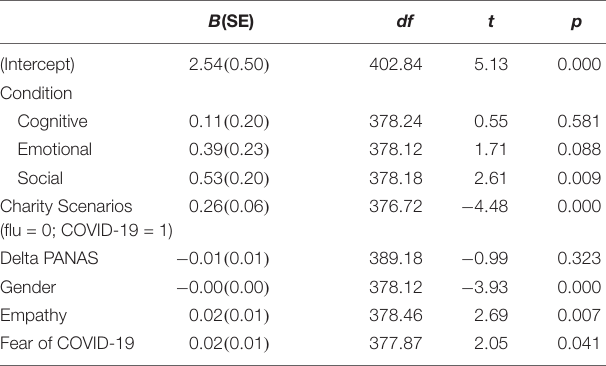
TABLE 3 | Multilevel linear regression model with willingness to help as the dependent variable, type of stress and target of the donation as